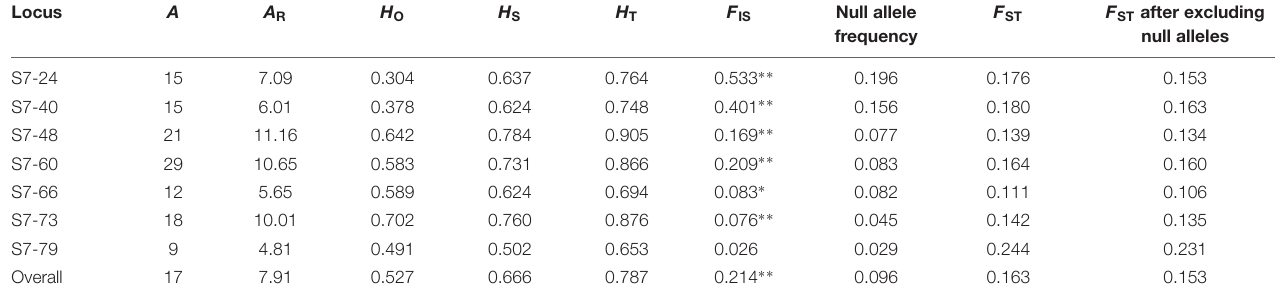
TABLE 2 | Characteristics of the seven nuclear microsatellites used in this study. Locus